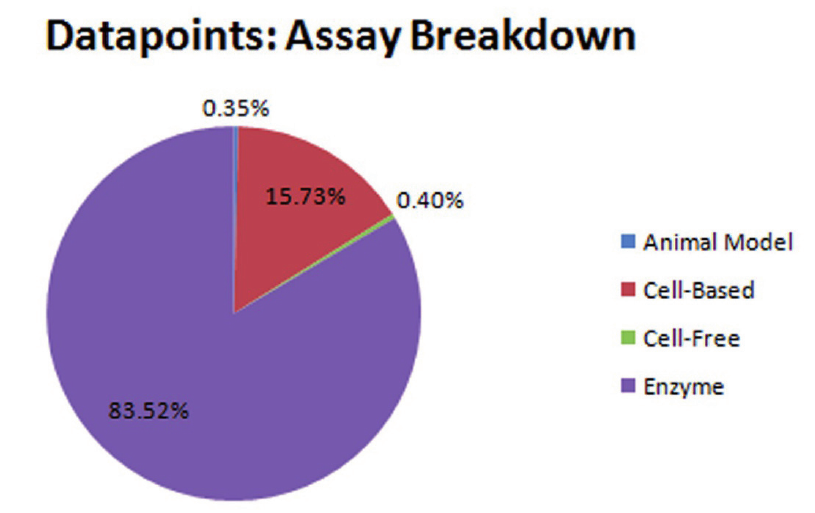
Figure 2. Data points share for each assay